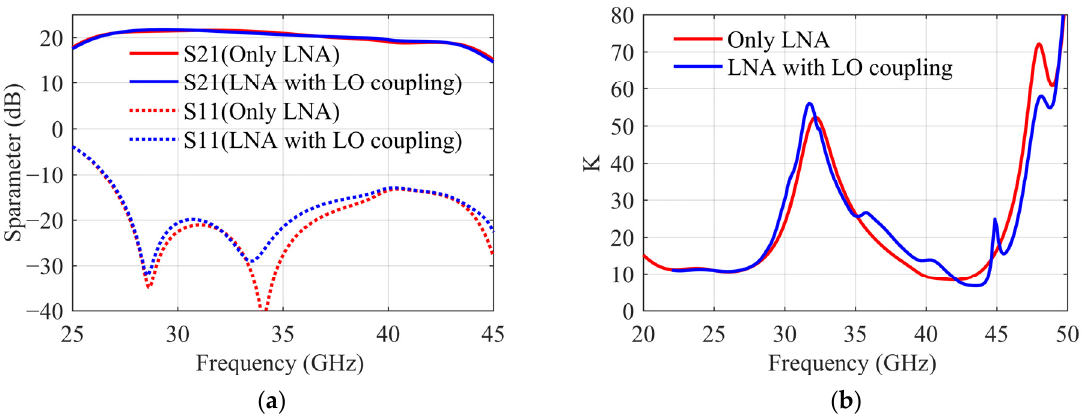
Figure 14. ( a ) LO coupling effect β on LNA S parameters. ( b ) LO coupling effect β on LNA stability factor.